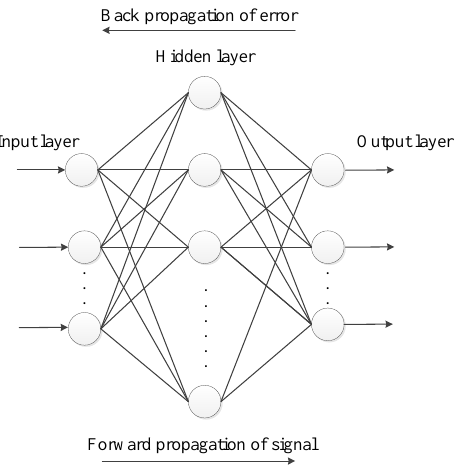
Figure 2. Architecture of the typical BP neural network.